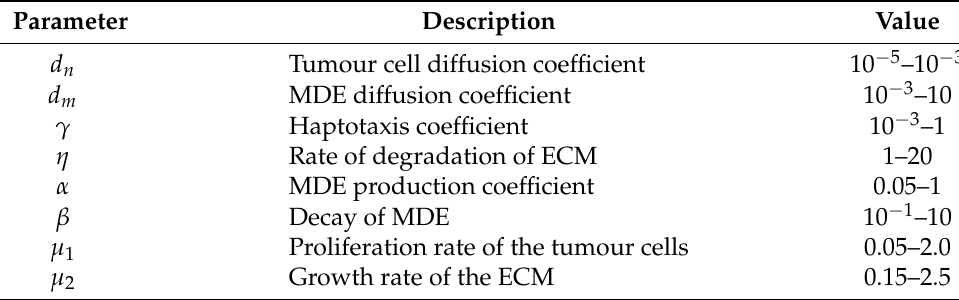
Table 1. The range of the estimated values of the model parameters.